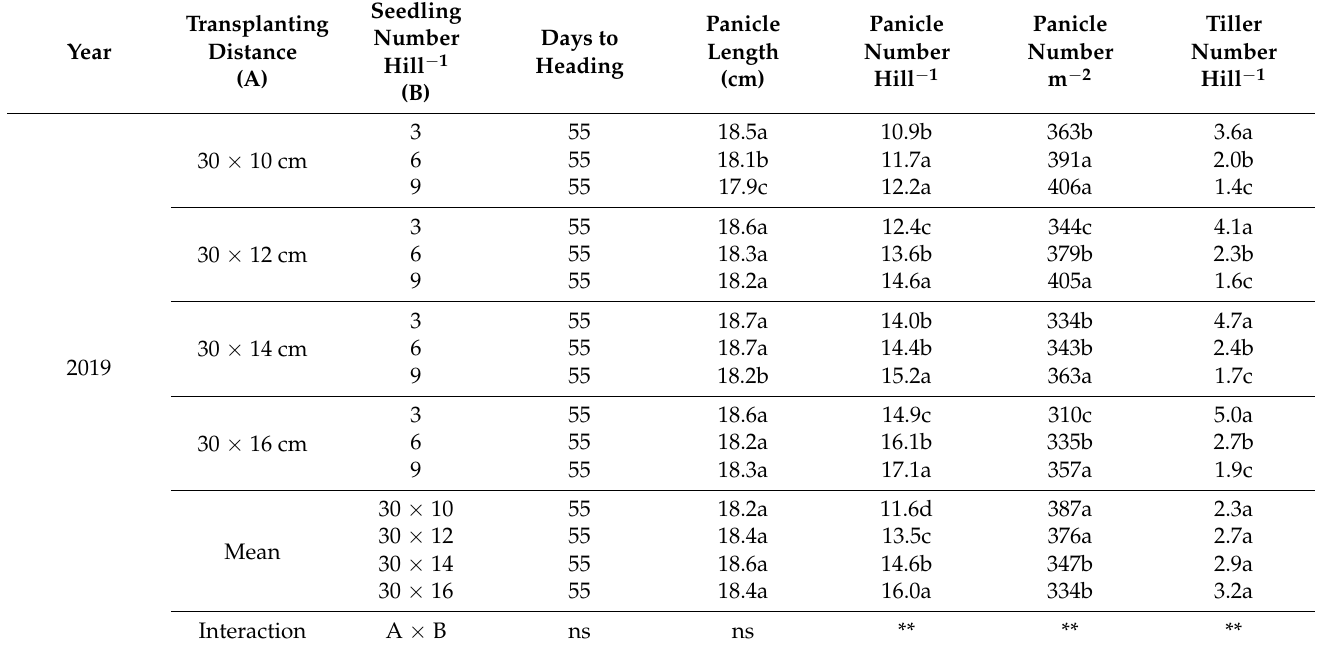
Table 1. Panicle-related traits according to transplanting